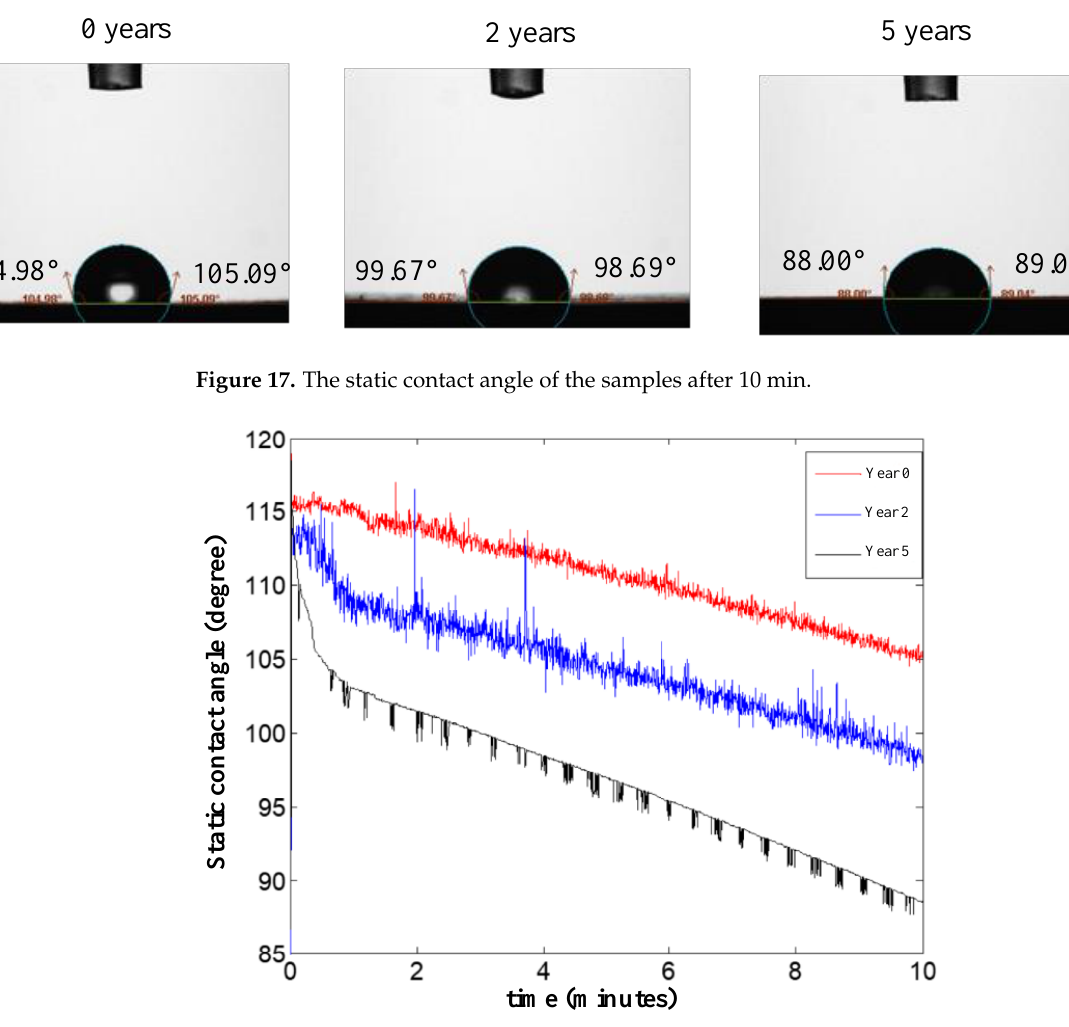
Figure 18. Static contact angle with a testing time of the samples. Table 6. Values of static contact angle of different silicone rubber